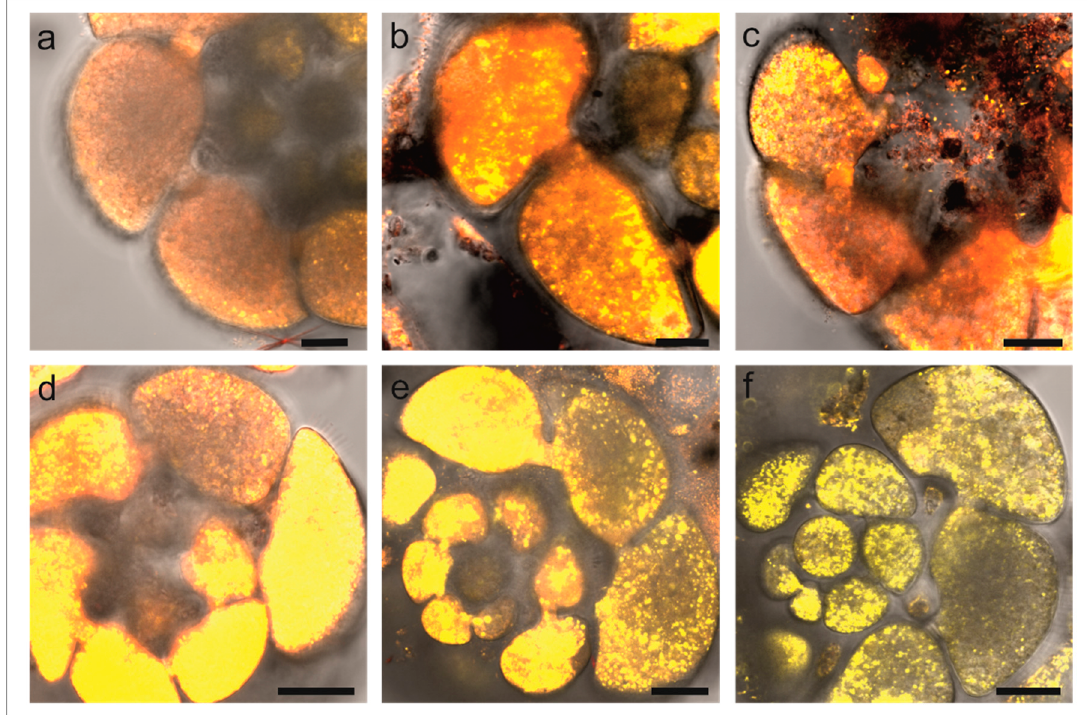
Figure 3. Effect of Cd exposure on lipid distribution of A . cf. parkinsoniana labeled with Nile Red (NR). Epifluorescence micrographs of single optical sections showing overlay of NR yellow and red fluorescence at 6 h: ( a ) Control; ( b ) 1 ppb; ( c ) 10 ppb; ( d ) 100 ppb; ( e ) 1 ppm; ( f ) 10 ppm. Scale bars: 25 µm.